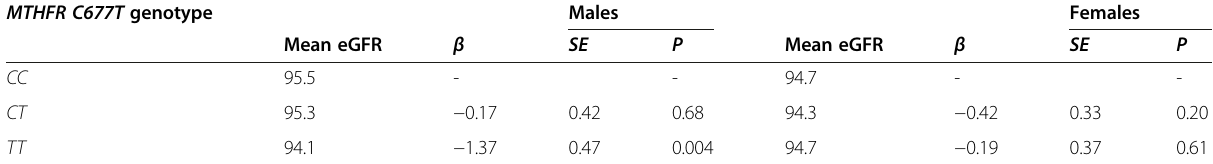
Table 2 Regression analysis of eGFR and MTHFR C677T genotype MTHFR C677T genotype